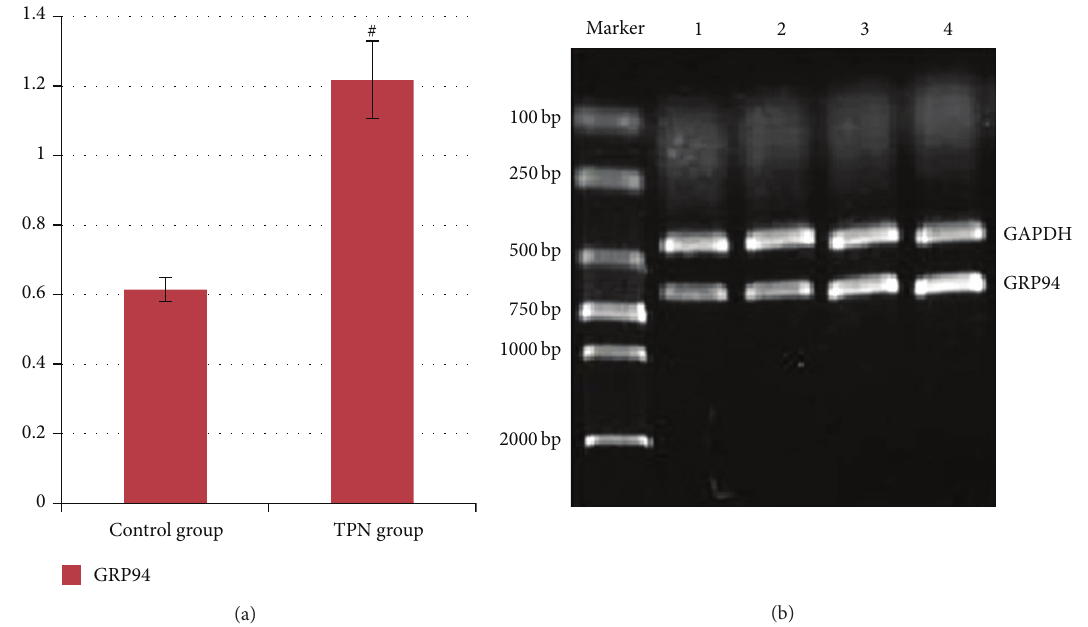
Figure 4: (a) A gray value histogram of GRP94 mRNA levels in liver tissue from the two groups. Compared with the control group, # 𝑃 < 0.01 . The bands were quantified as the relative integrated optical density (IOD) values of the ratio of GRP94/GAPDH for two groups, mean ± SD, 𝑛 = 8 . (b) Liver tissue GRP94 mRNA amplified by RT-PCR and analyzed by electrophoresis. Lanes: marker, DNA marker; 1 and 2, control group; 3 and 4, TPN